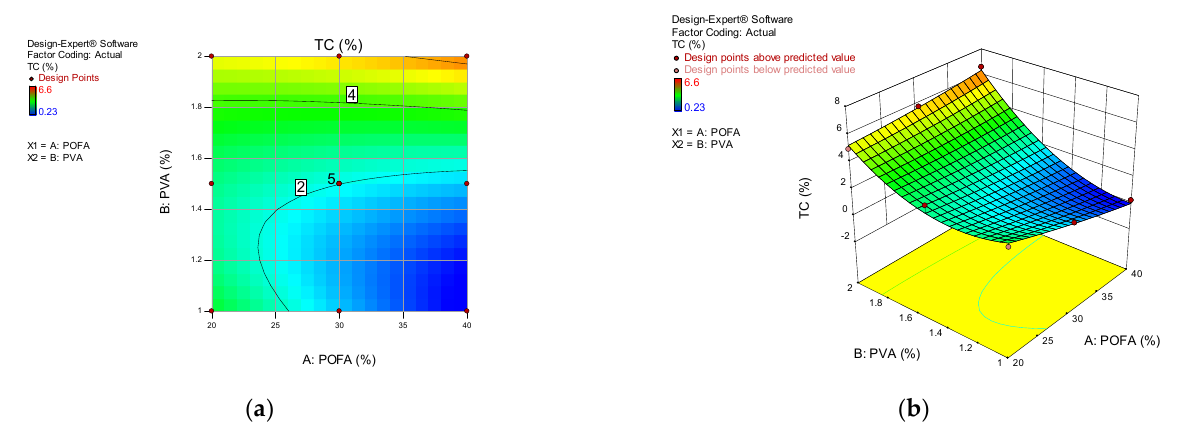
( b ) Figure 21. ( a ) 2D Contour Plot and ( b ) 3D Response Surface Diagram for Tensile Strength.